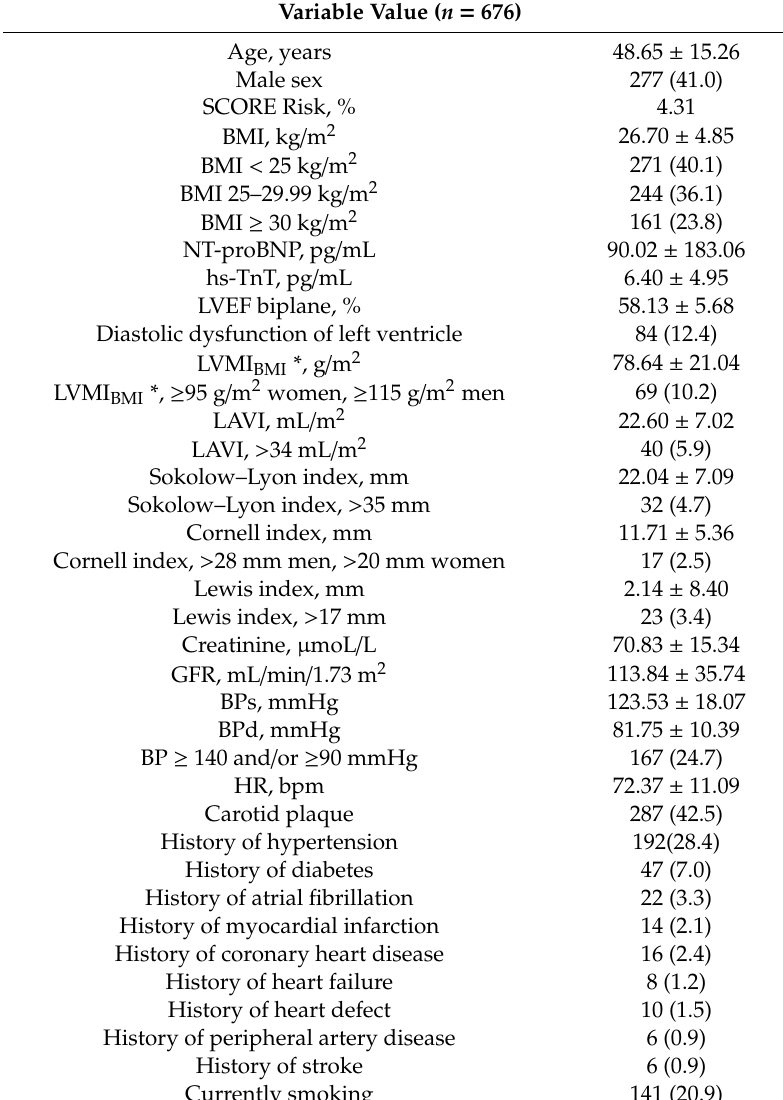
Table 1. Characteristics of the study